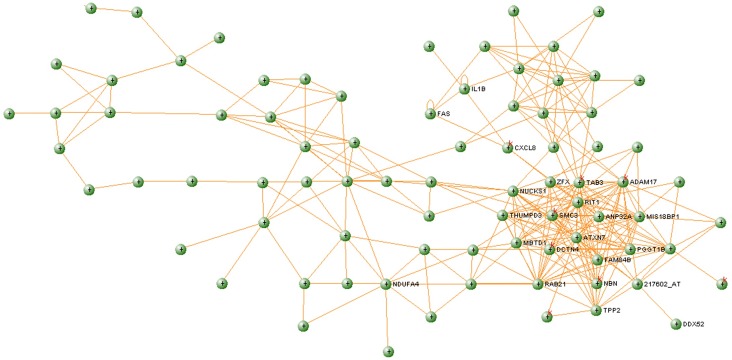
Royalblue module extracted from the T1D network.